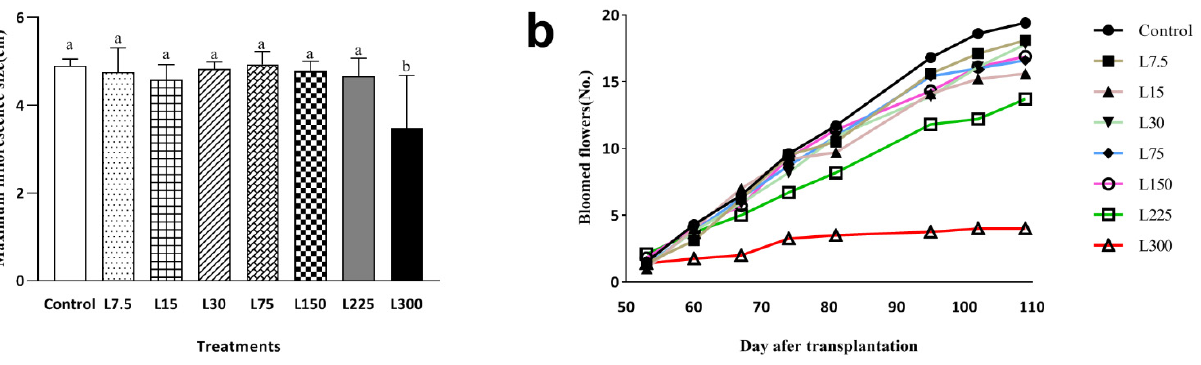
Figure 3. Effect of Cd stress on flowering of Tagetes patula . ( a ) Maximum influence size and ( b ) bloomed flowers were measured during the whole flowering phase. Each bar in ( a ) denotes the mean of 10 replicates, with standard error based on means (MSE). Different letters indicate significant differences among Cd concentrations within the same growth stage and organ compared by Fisher’s least significant differences (LSD) test at p ≤ 0.05. Each dot in ( b ) represents the mean of 10 replicates. Table 2. Effects of Cd stress on flowering parameters of Tagetes patula.